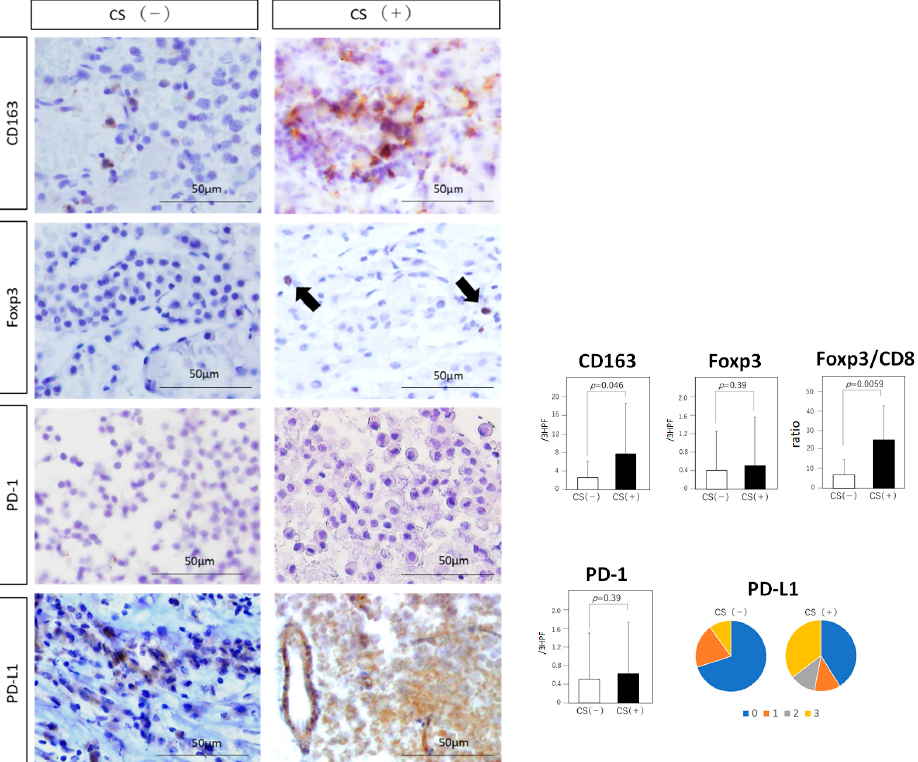
Figure 4. Analysis of immunosuppressive cells and immune checkpoint molecules. are shown in both groups. Black arrow: tumor cell showing positive Foxp3 expression. The number of CD163 ( + ) tumor-associated macrophages (TAMs) and Foxp3 / CD8 ratio are significantly higher in the CS ( + ) group than in the CS ( − ) group (CD163: p = 0.046, Foxp3 / CD8: p = 0.0059). The score of PD-L1 tends to be higher in the CS ( + ) group than in the CS ( − ) group ( p = 0.050). Expressions of Foxp3 and PD-1 do not reach statistical significance (Foxp3: p = 0.39, PD-1: p = 0.39). Data represent the mean ± standard error of mean (CD163, Foxp3, PD-1 and Foxp3 / CD8 ratio, student’s t -test; PD-L1, Mann-Whitney U